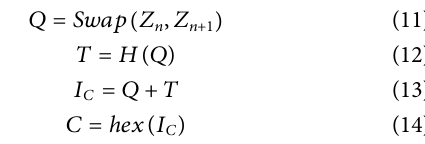
Frontiers in Blockchain |